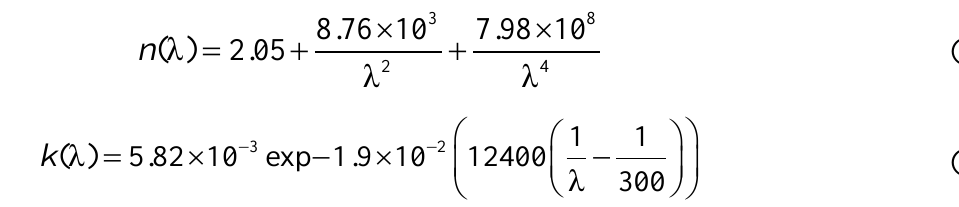
thin 3 samples, 3